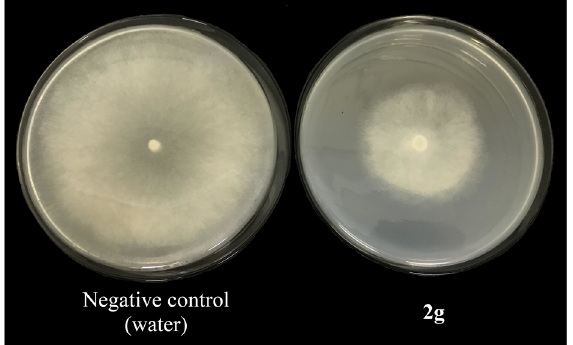
Figure 3. Growth inhibition of S. sclerotiorum in addition of compound 2g to the medium at a concentration of 0.1 mg/mL.